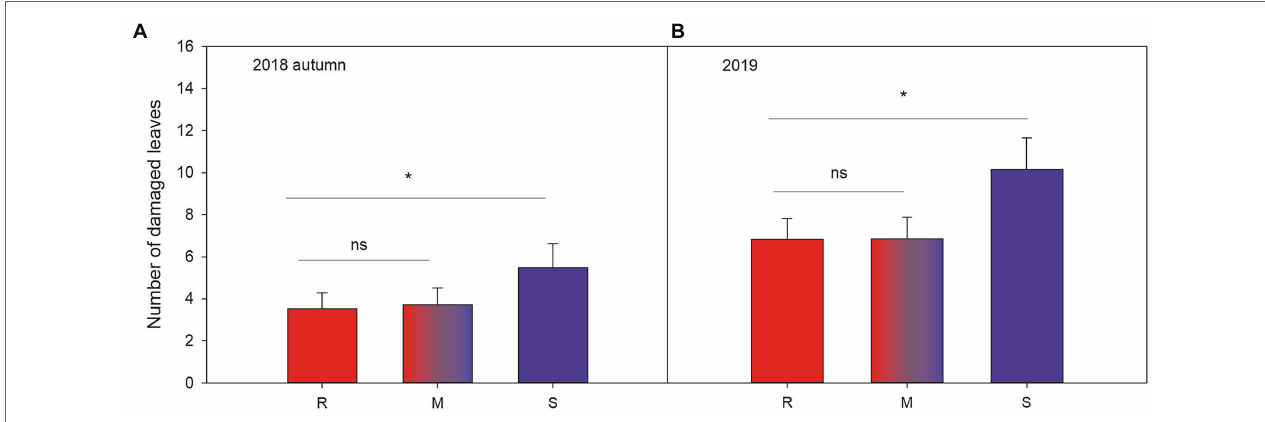
FIGURE 2 | Significant effects ( Table 2 ) of plot resistance ( resistant , susceptible and 50:50 mixture ) during the last scoring occasion (A) autumn (mid-September) in 2018 and the only scoring occasion (B) during mid-summer (mid-July) in 2019 on number of woodland strawberry ( Fragaria vesca ) leaves damaged by herbivores (mean ± SE). Letters along the x-axis indicate different treatments in (A) : R = resistant varieties (red), S = susceptible varieties (blue), and M = 50:50 mixture of resistant and susceptible varieties (red and blue). Stars indicate statistically significant differences by Tukey’s test ( p < 0.05) described in the